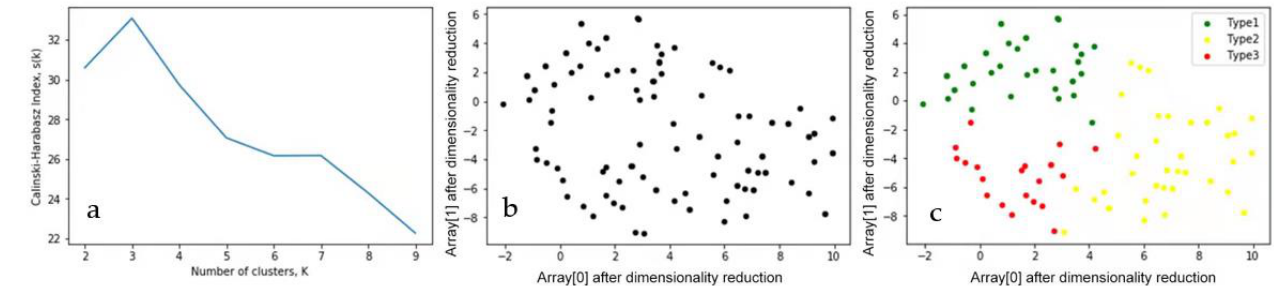
Figure 4. Results of K-means clustering ( a ), raw data ( b ), and clustered data ( c ) of landslide adaptation strategies.